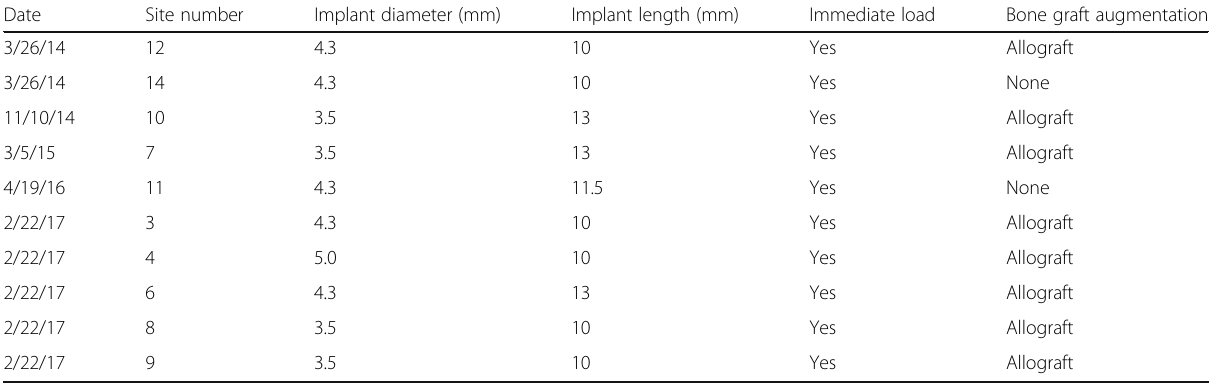
Table 2 Chronological timeline of the implant therapy of the